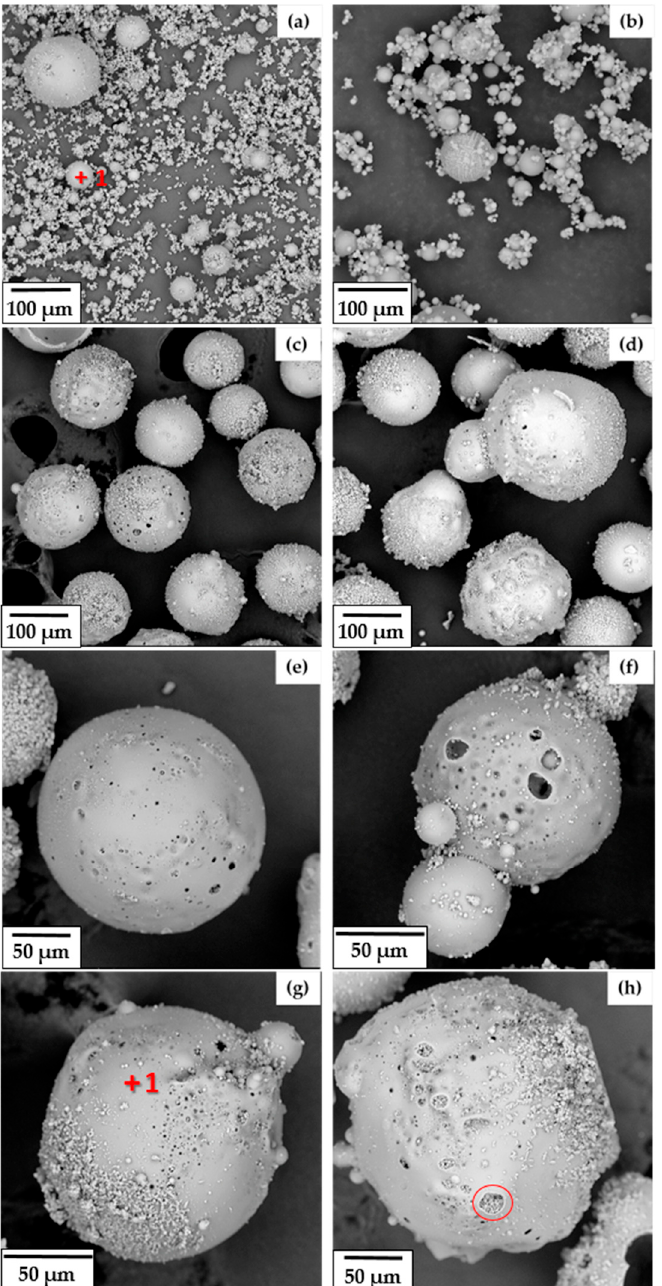
Figure 4. Scanning electron microscopy (SEM) images of ( a , b ) fly ash and ( c – h ) cenospheres collected